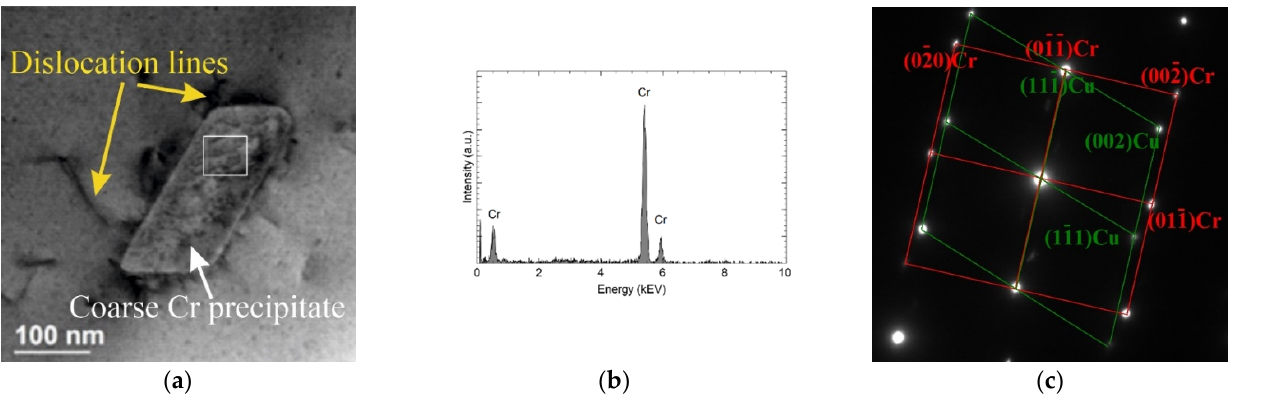
Figure 9. STEM-BF image of coarse Cr precipitate ( a ), the result of the chemical composition analysis ( b ), SAED from the [011] fcc Cu zone axis ( c ).